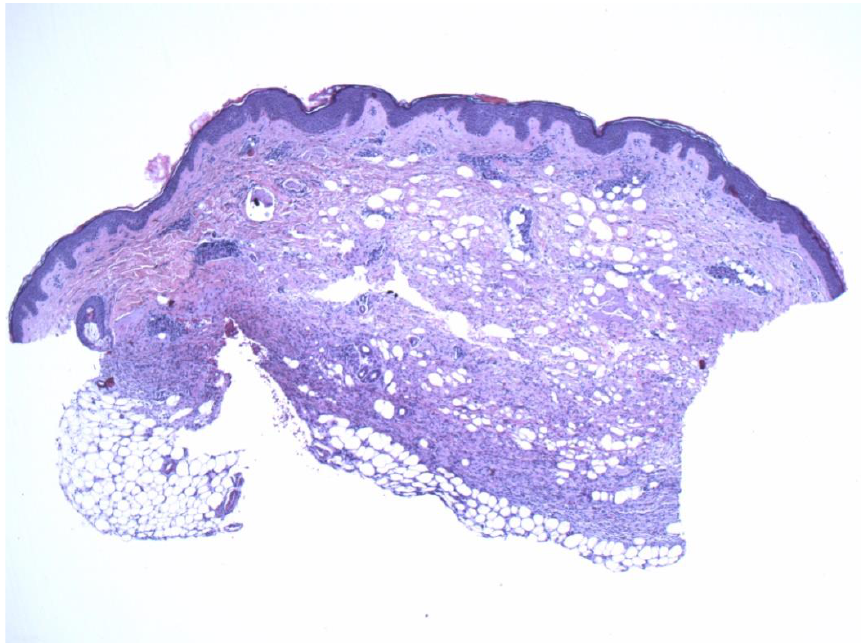
Figure 2. A thin strip of spindle cells is noted in the deeper dermis with subjacent fat. The mid and superficial dermis show sparse spindle cells with atrophic changes (4 ×